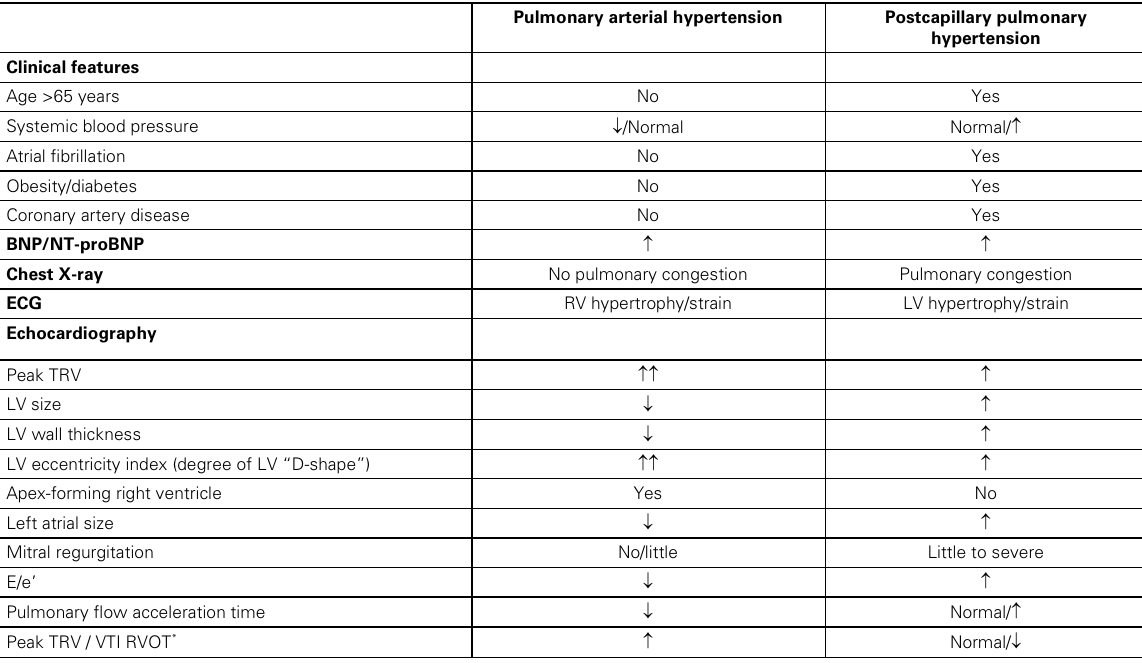
Table 3: Clinical features and noninvasive findings favouring pulmonary arterial hypertension or postcapillary pulmonary